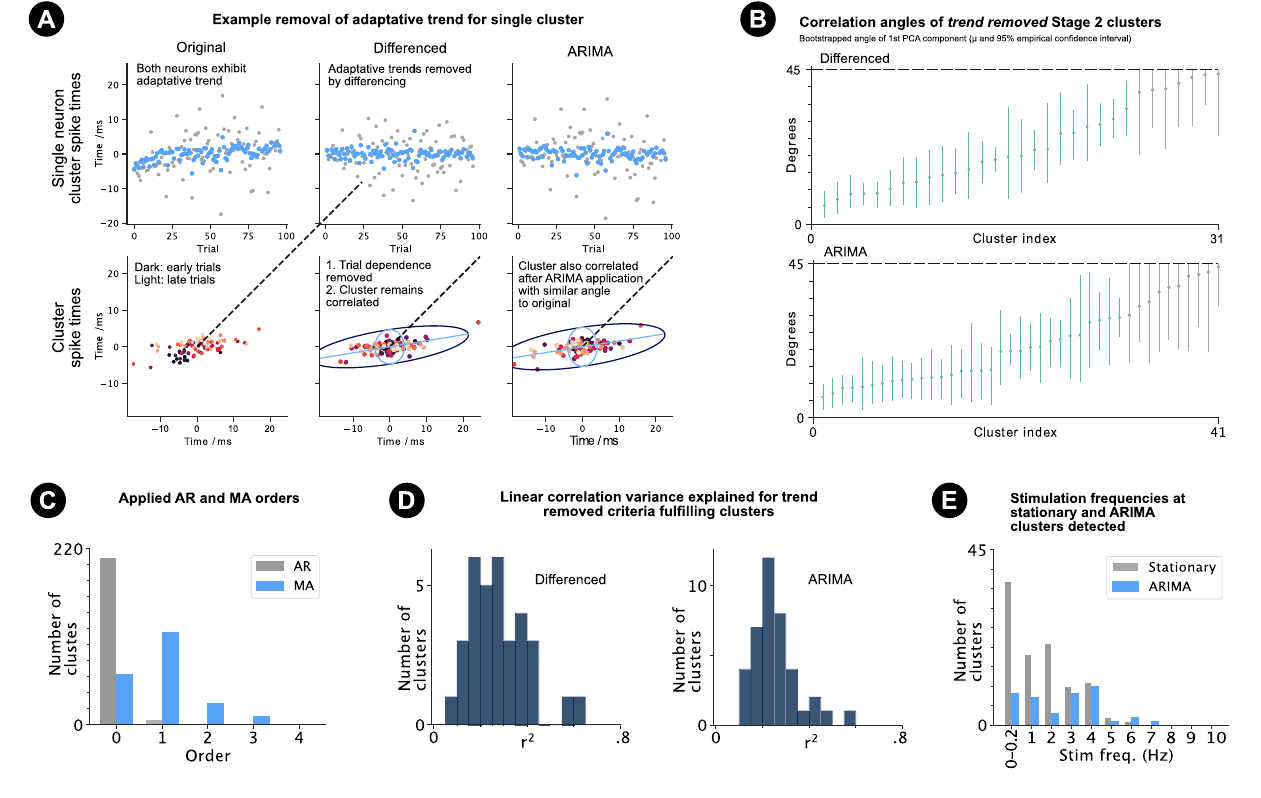
Figure 6. Time series modelling and cluster frequency-dependence. ( a ) For an example cluster, the original spike times do not fulfil the stationarity criteria (Methods) but do after the application of differencing and ARIMA modelling. The factor analysis predicted state-dependent response distributions are therefore presented for the cluster after differencing and ARIMA modelling ( 4 σ ellipse; bottom centre and bottom right). It is clear that the adaptative trends have been removed by differening and ARIMA modelling but the clusters remain correlated with similar angles to the original cluster. ( b ) Predicted angles and 95% empirical confidence intervals of differenced and ARIMA modelled criteria fulfilling Stage 2 clusters. Angles significantly different from 0 45 ◦ coloured green. Grey otherwise. ( c ) Order of AR and MA models fit to the single neuron cluster spike times of differenced clusters. ( d ) Linear regression r 2 values for criteria fulfilling differenced (left) and ARIMA (right) clusters. ( e ) Histogram showing number of stationary Stage 2 clusters and criteria fulfilling ARIMA modelled clusters (by stimulation